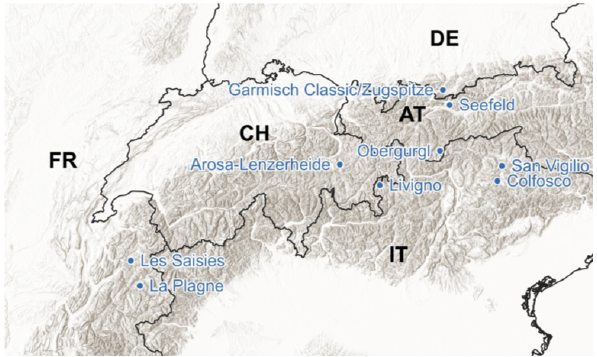
Figure 1. Locations of the PROSNOW ski